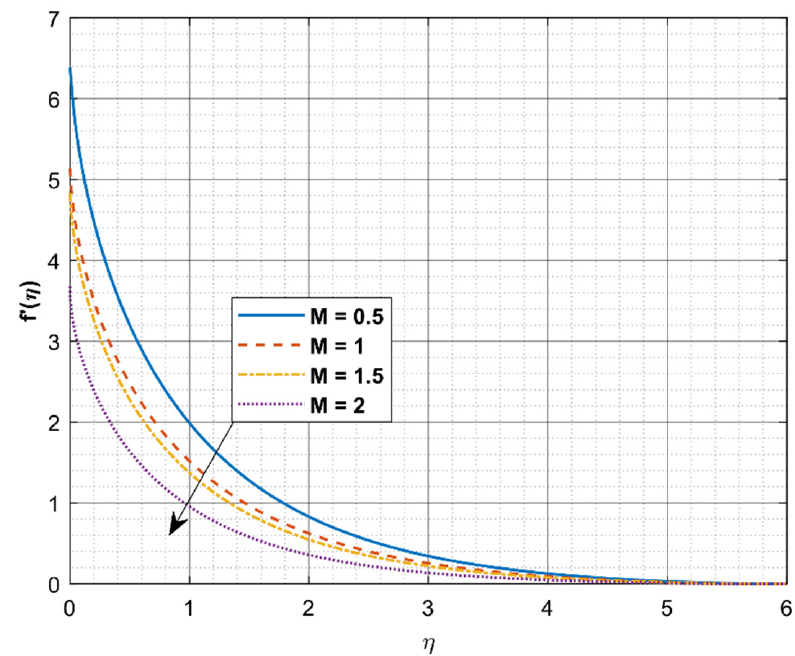
Figure 2. Influence of M on f (cid:48) ( η ) .